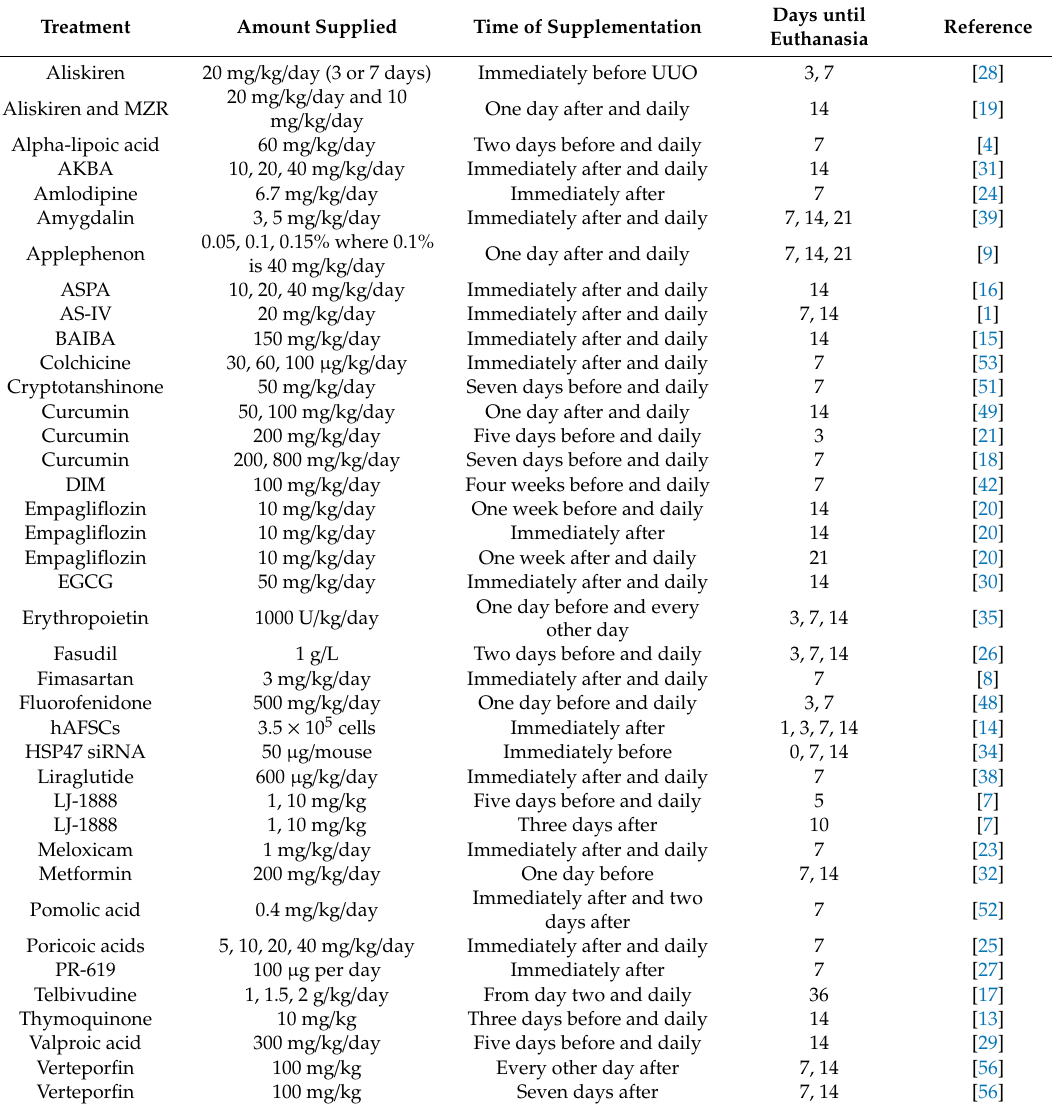
Table 3. Summary of the treatments to ameliorate renal fibrosis discussed in this review.